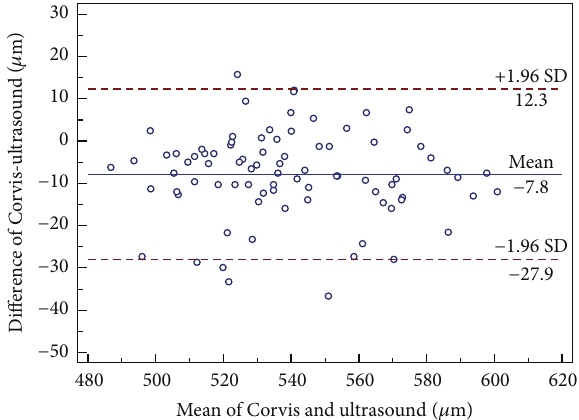
Figure 2: Bland-Altman plot demonstrating central corneal thick- ness measurements obtained using corneal dynamic Scheimpflug analyzer Corvis ST and ultrasound pachymetry against the mean values for both devices. The 95% limits of agreement are represented as the upper and lower